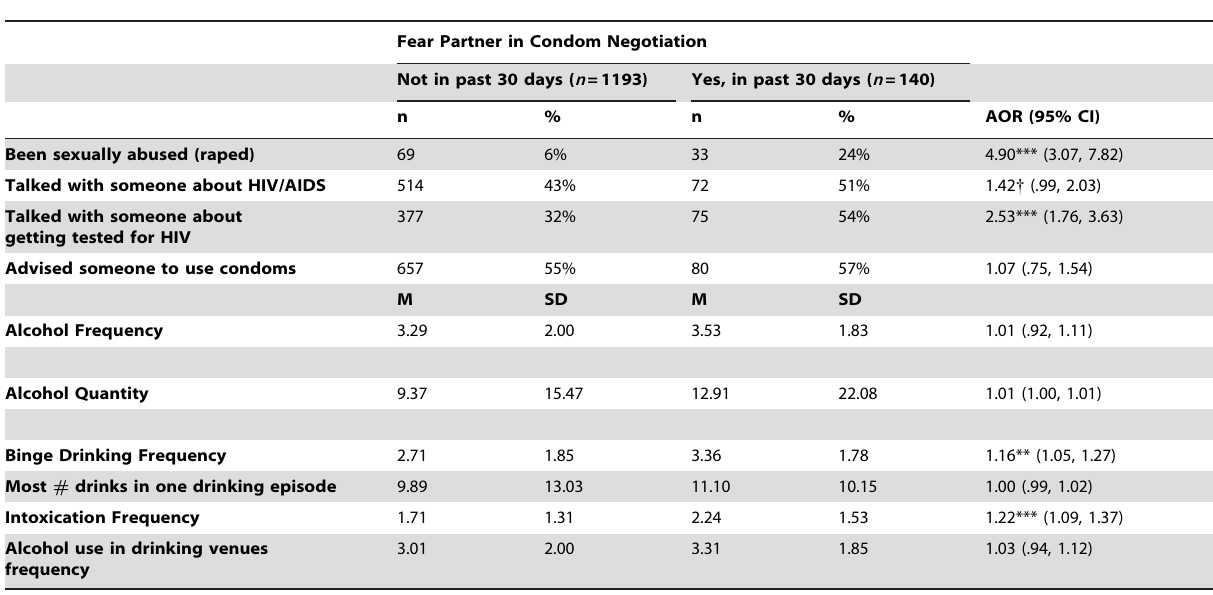
Table 2. Experiences and alcohol use in past 30 days by fear of partner in condom negotiation ( n